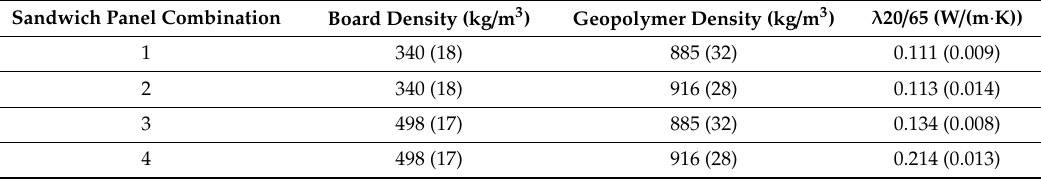
Table 5. Average densities of materials and thermal conductivity of